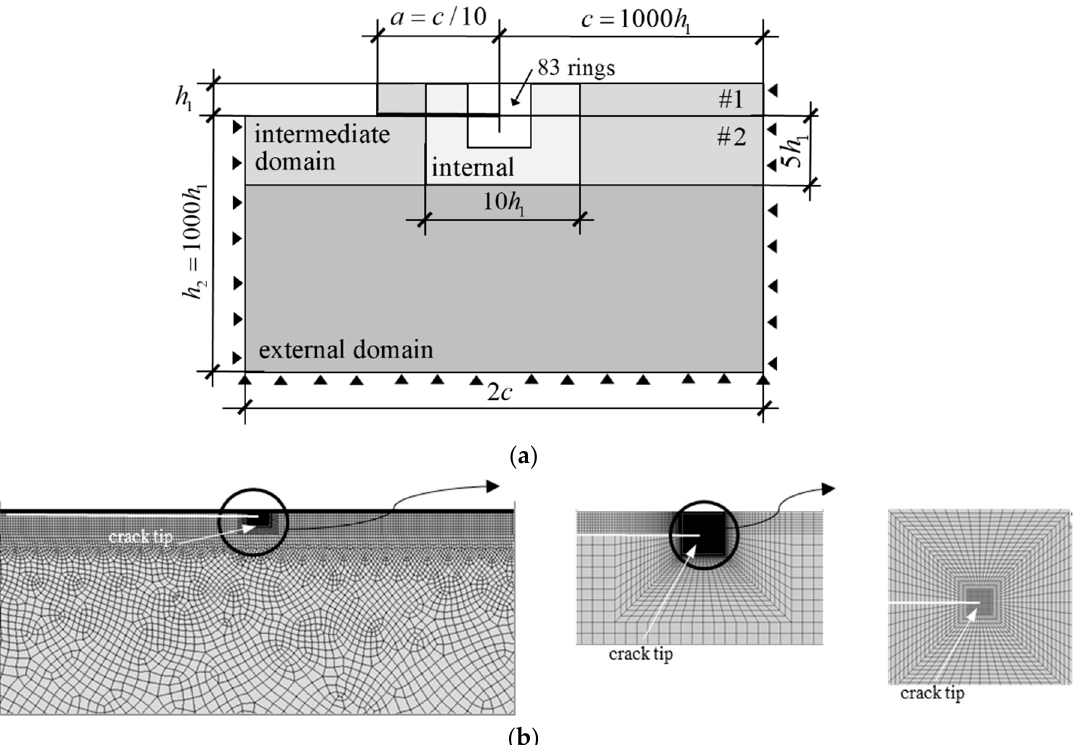
Figure A1. ( a ) Dimensions and domains of the finite element model in ANSYS. ( b ) Zooms of the Finite element mesh showing internal, intermediate and external domains (parts of).